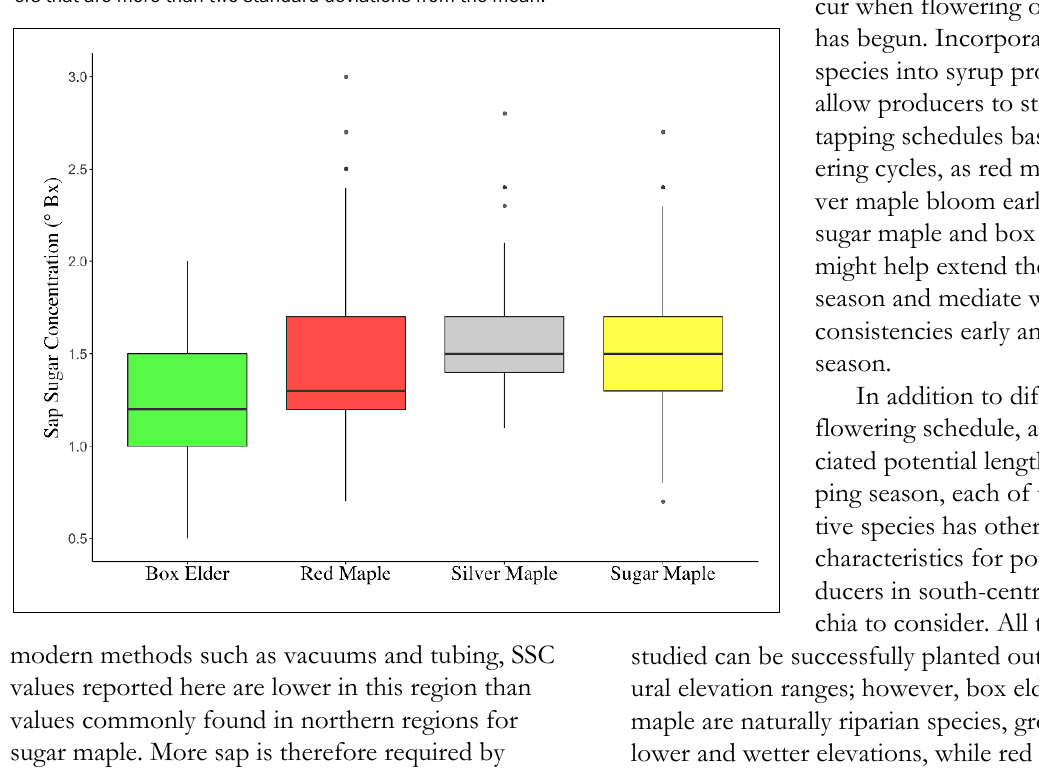
Figure 3. Sap Sugar Concentration by Species The horizontal line bisecting each box represents median values, with 50% of data points falling within the box, and the upper and lower 25% of data points falling along the vertical lines above or below the box. Filled circles placed above or below the plot represent outli- ers that are more than two standard deviations from the